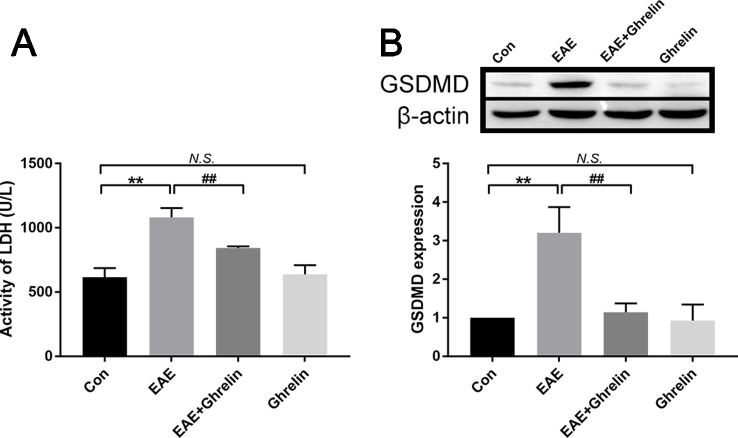
Treatment of ghrelin inhibited pyroptosis in EAE rats. (A) Expression of LDH in serum was measured by an LDH assay kit, n = 10. (B) Representative western blot image of changes in the expression level of GSDMD. β-Actin was used as internal control to calculate relative expression (n = 5). Data were shown as mean ± SD.**P 0.01 versus the control group, ##
P 0.01 versus the EAE group. NS, not significant. Con, control.